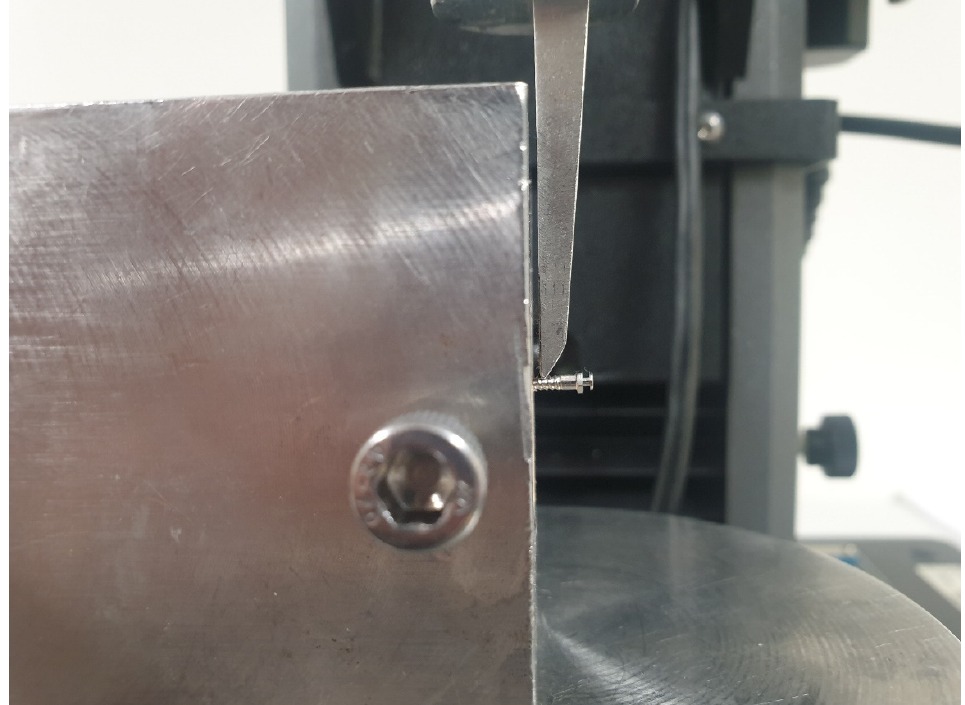
Figure 3. Digital photograph of the horizontal resistance test set-up.